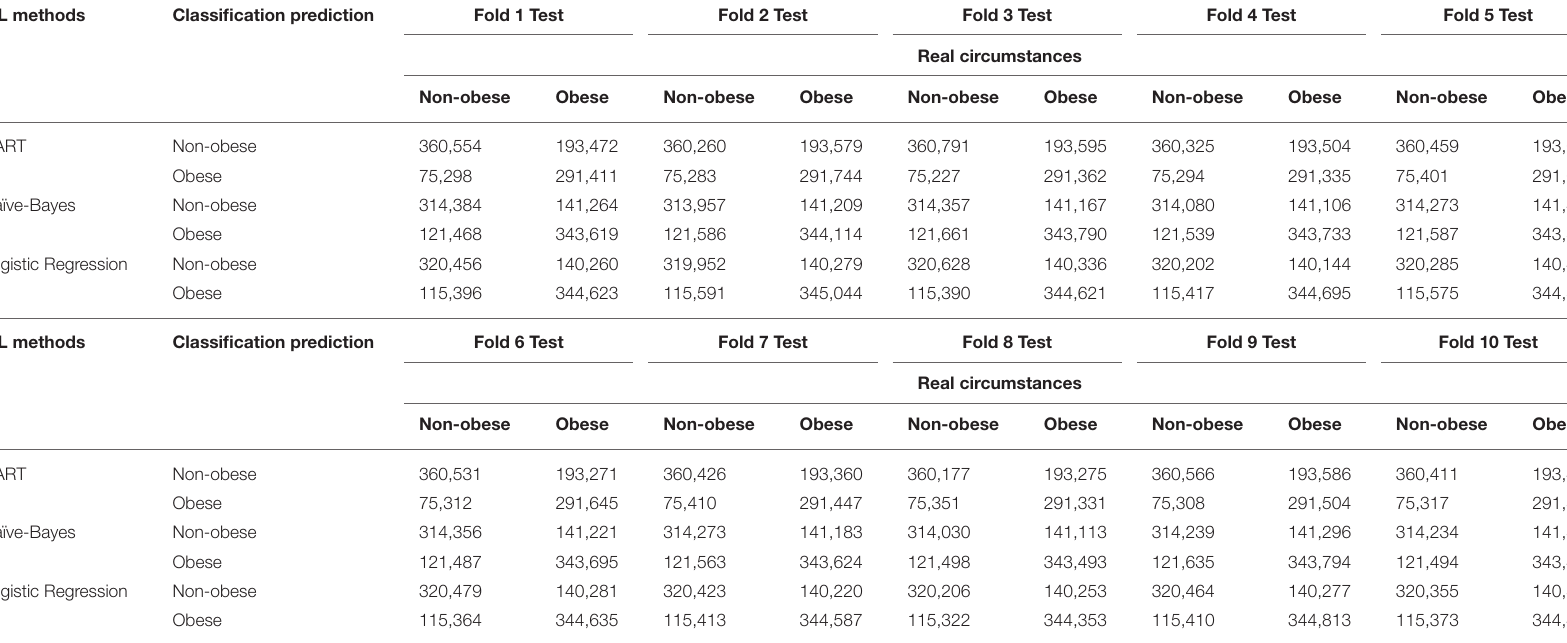
TABLE 2 | Comparison of classification accuracy with 10-fold CV based on the obesity test data using three models with confusion